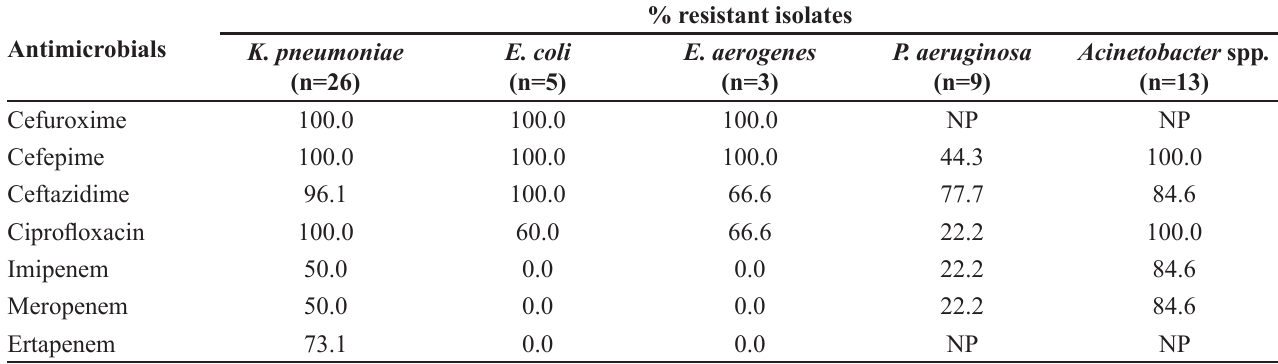
TABLE II - Antimicrobial resistance profile of Gram-negative bacteria isolated from patients in an ICU in southern Brazil, from March 2012 to August 2013